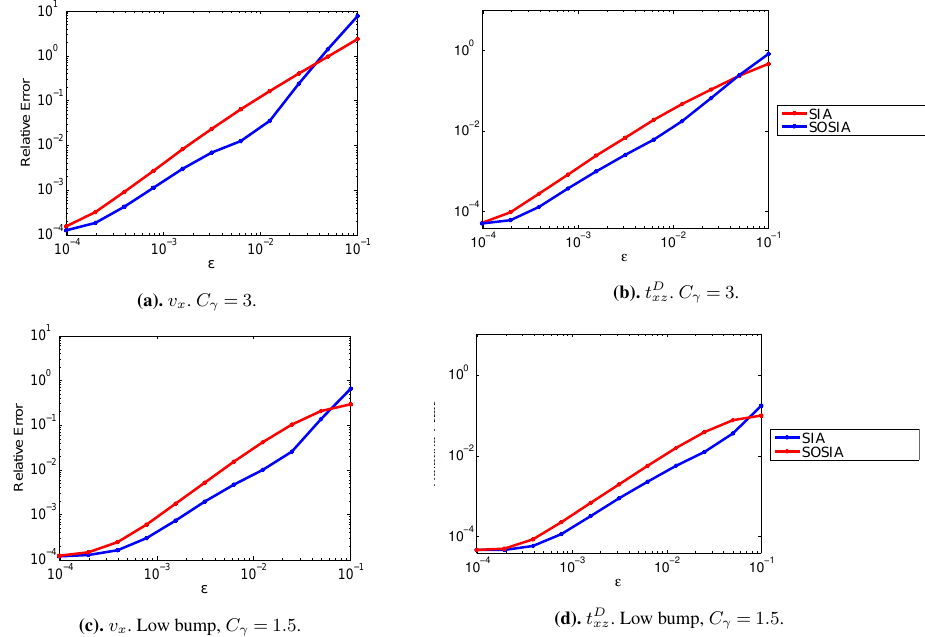
Fig. 4. Relative error of horizontal velocity v x and vertical shear stress t D xz for both SIA (red) and SOSIA (blue) for µ = 0 . 5 and µ = 0 . 1 . σ res = C γ ρg [ H ] (cid:15) 4 / 3 is only used when needed in the denominator of the expressions.